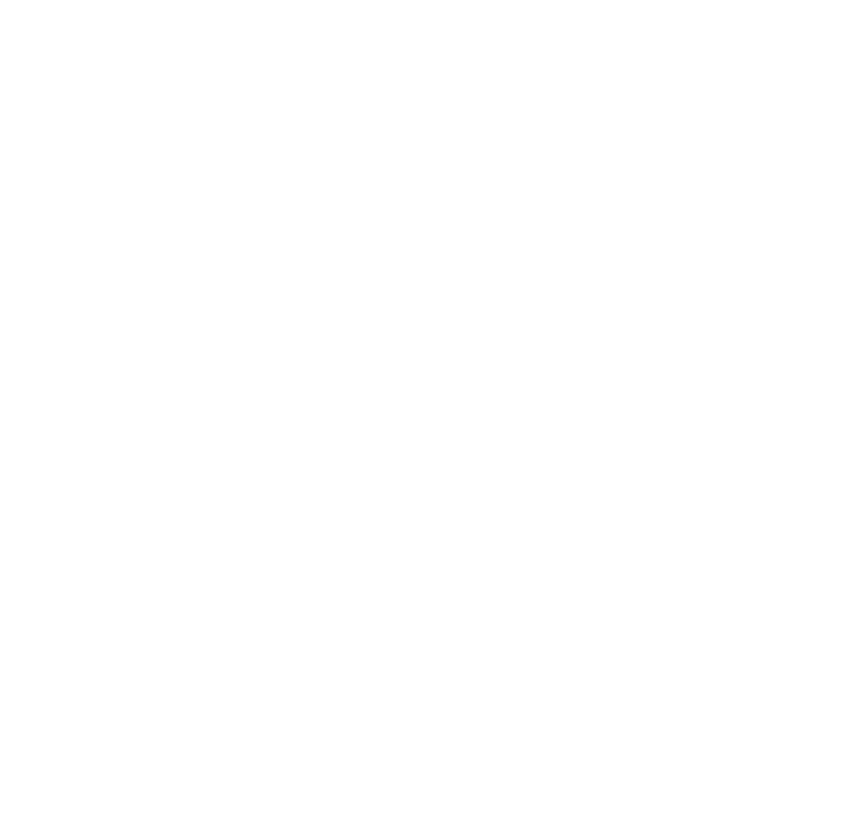
Frontiers in Physiology |